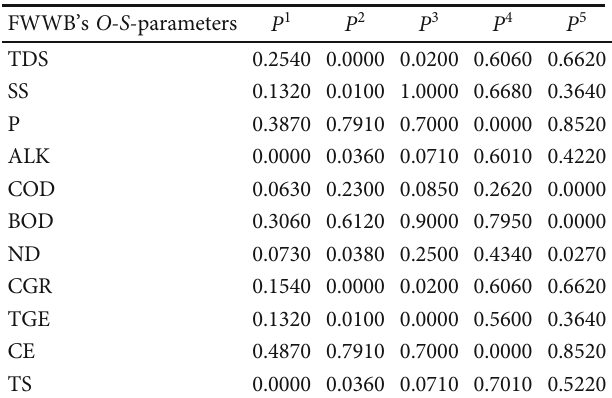
Table 7: Computed normalized values of FWWB ’ s O - S -parameters corresponding to FWWB points.